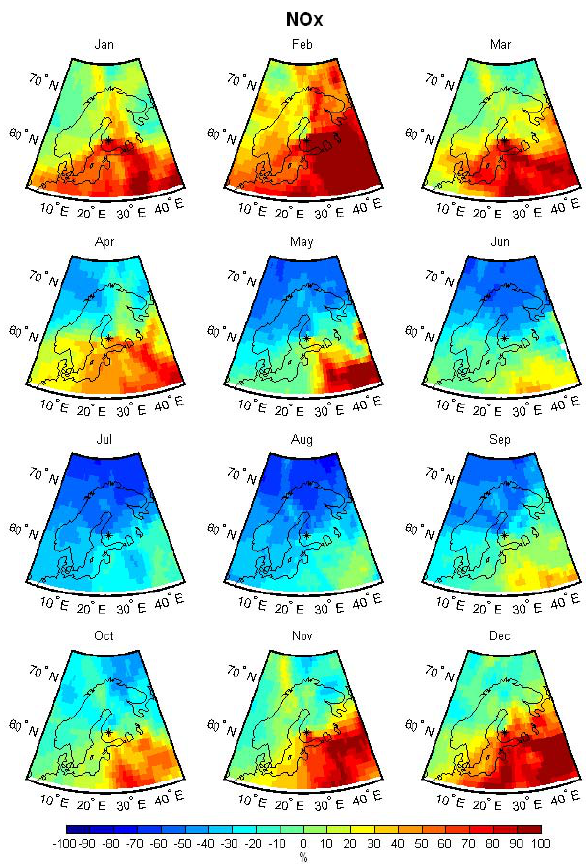
Fig. 9. Deviation from measured average O 3 concentration in Hyyti¨al¨a according to transport directions. Monthly concentration fields are produced for years 1996–2008. Fields are normalized to the mean concentration (32.6 ppb) of the whole measurement pe- riod. Hyyti¨al¨a is marked with a